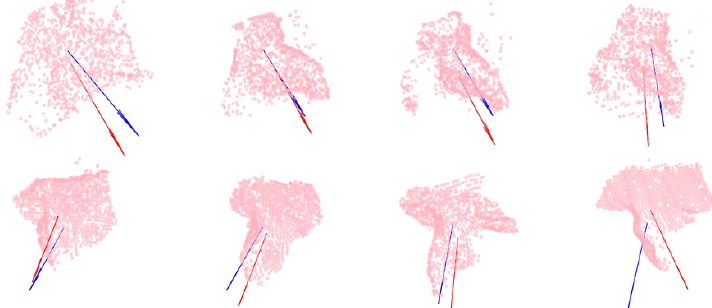
Figure 16. Predictions (red) on data from the live test shown along side human demonstrations